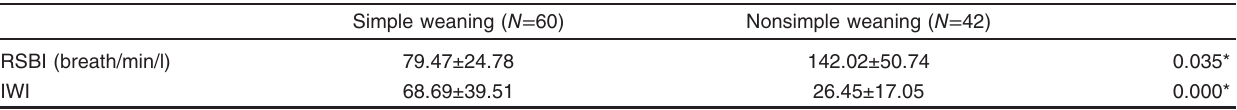
Table 4 Outcome variables